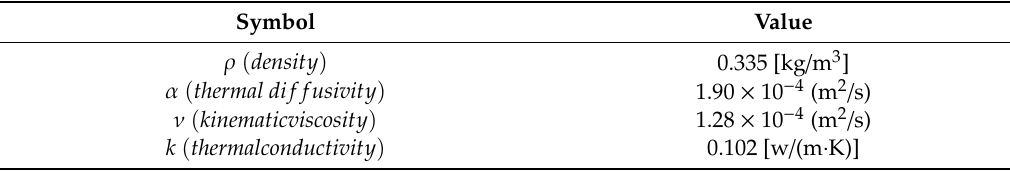
Table 2. Transport thermo-physical properties of flue gaseous mixture